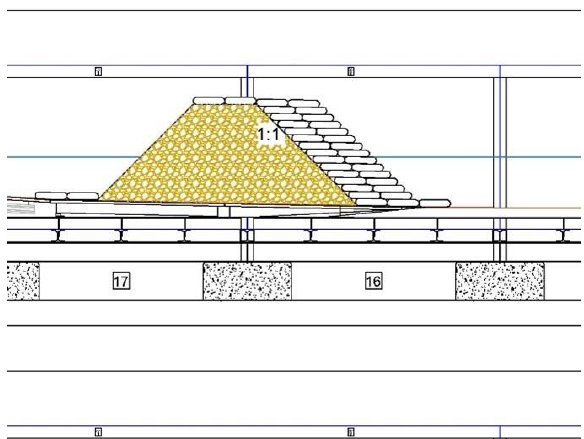
Figure 5. GSC revetment structure with a slope of 1:1 ( lateral and front views).